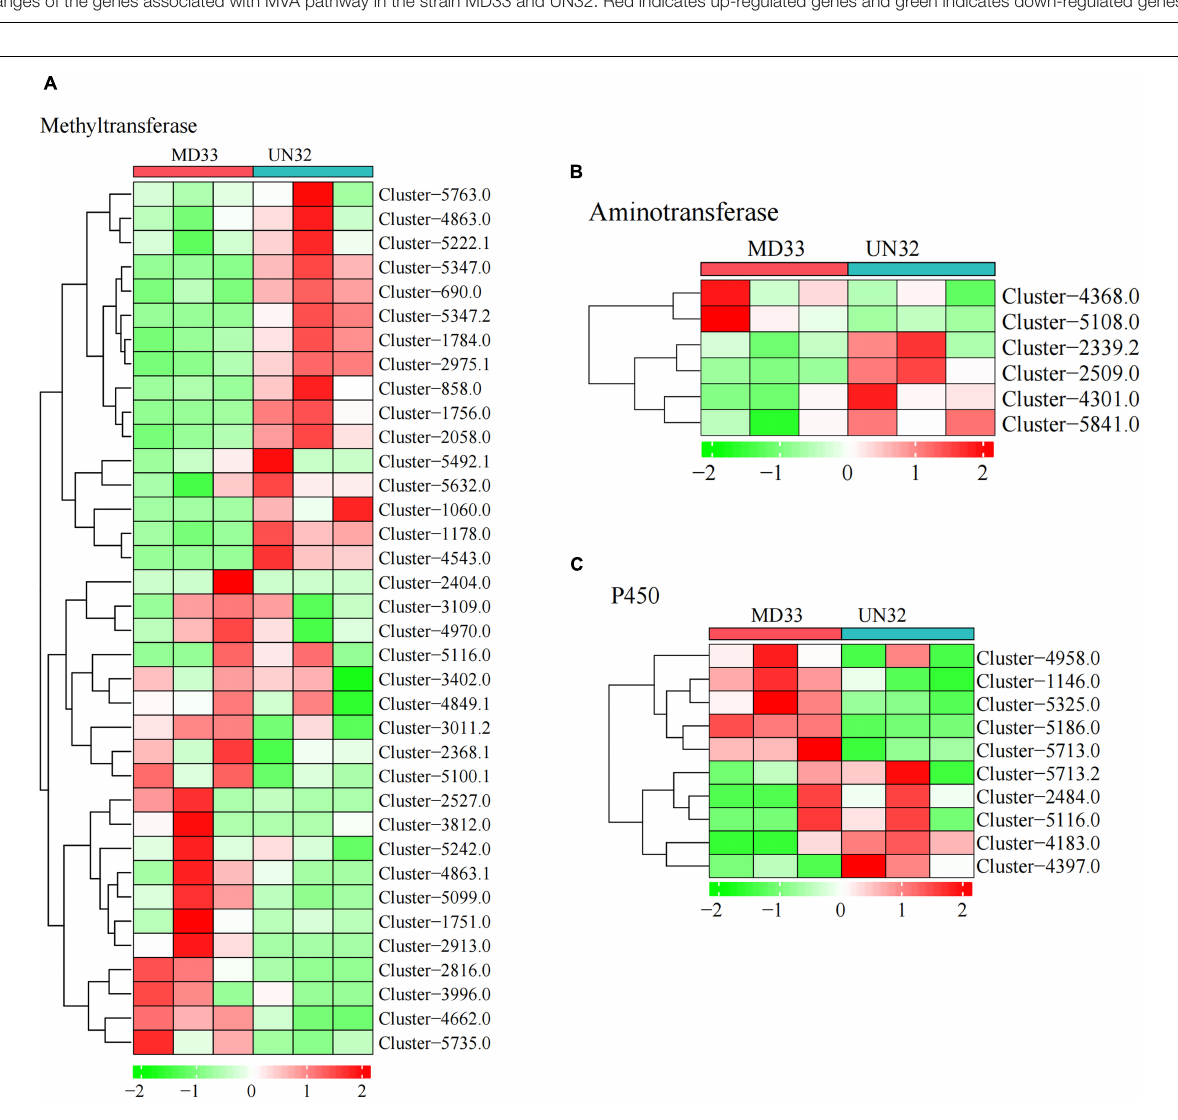
Frontiers in Microbiology |